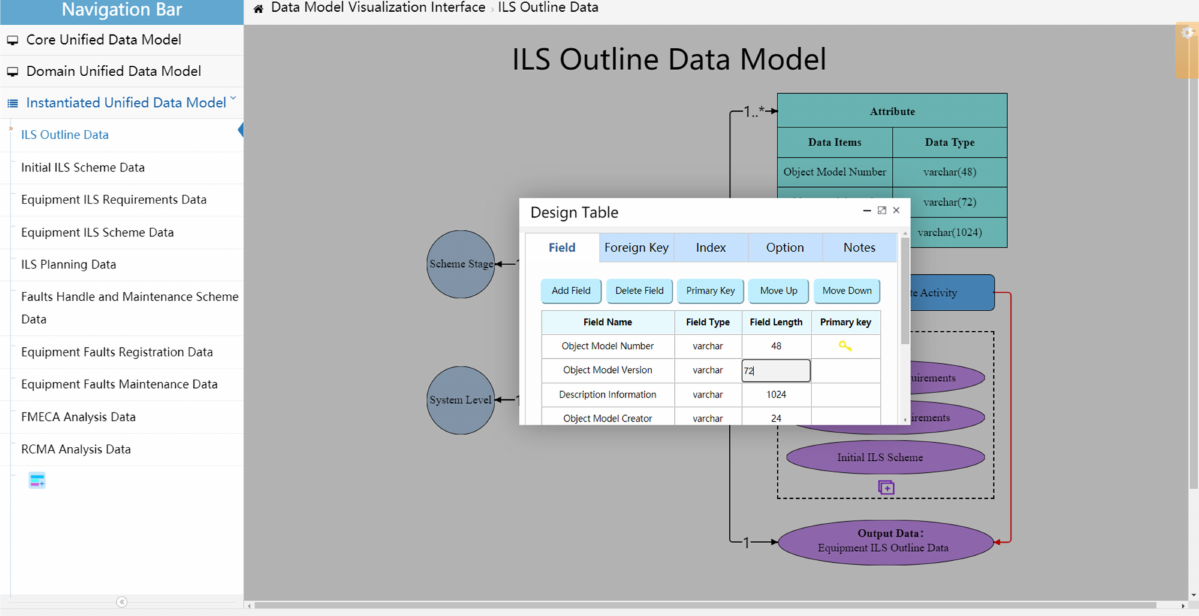
Figure 16. Detailed data table designing.